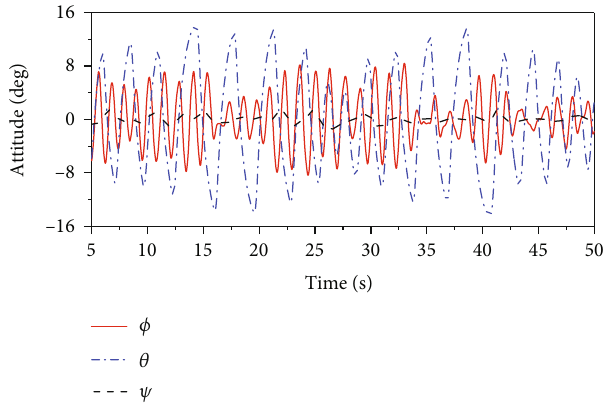
Figure 14: Attitude trajectories in time history.